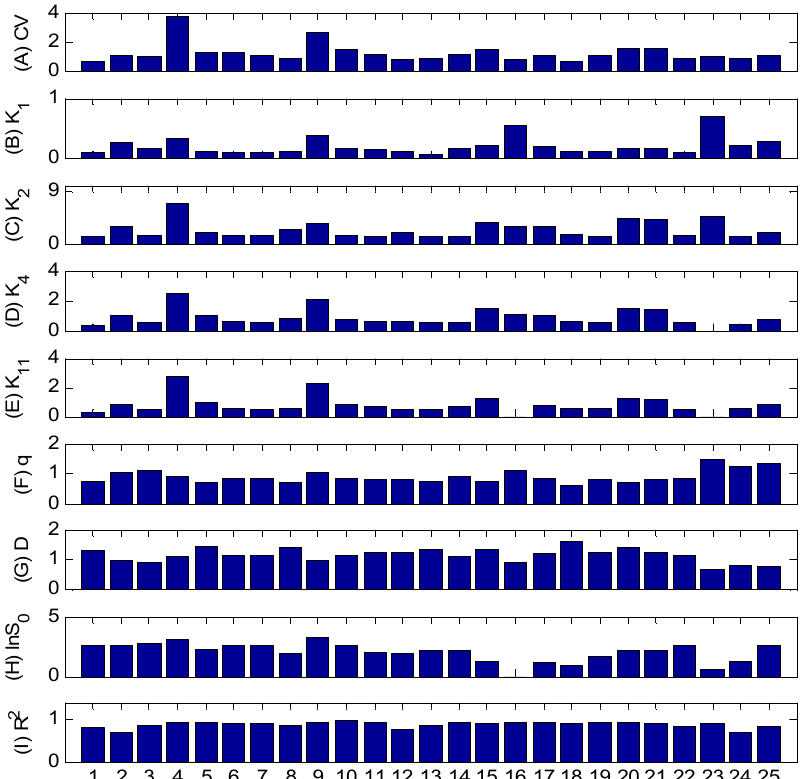
Figure 7. Index of the primary characteristics of the provincial urban system in China during the TCE (CV: coefficient of variation; K1, K2, K4, K11: urban primacy index; q : Zipf dimensions; D: fractal dimension; ln S 0 : logarithm of theoretical value of the first city size; R 2 : determination coefficient of rank size equation).